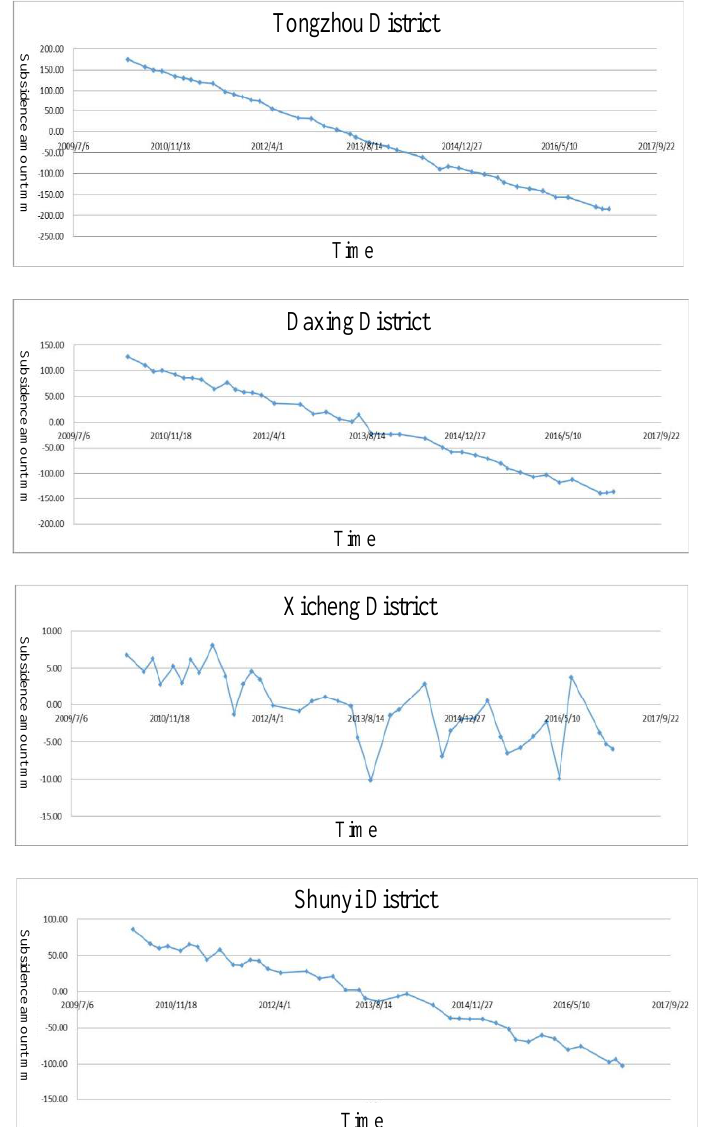
Figure 4. Time-dependent Variation Trend of Subsidence Value of PS Points in the Four Districts Within the coverage area of image data, severe subsidence has occurred in both Tongzhou District and Daxing District. With passage of time, the subsidence value of the PS points keeps on increasing. The subsidence variations from April 2010 until Jan. 2017 are 160mm~-186mm (Tongzhou) and 127mm~-181mm (Daxing)